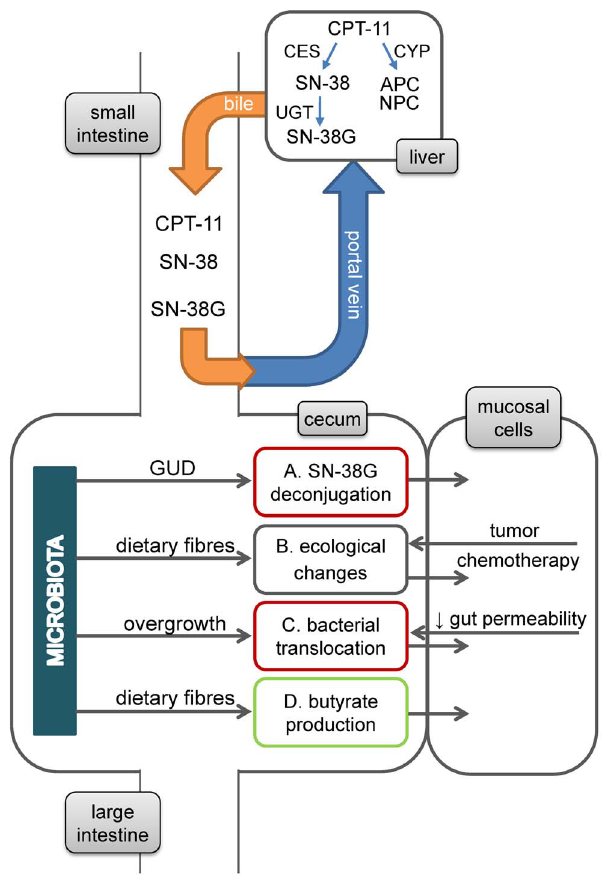
Figure 1. Potential roles of intestinal microbiota in develop- ment and mitigation of CPT-11 (irinotecan,